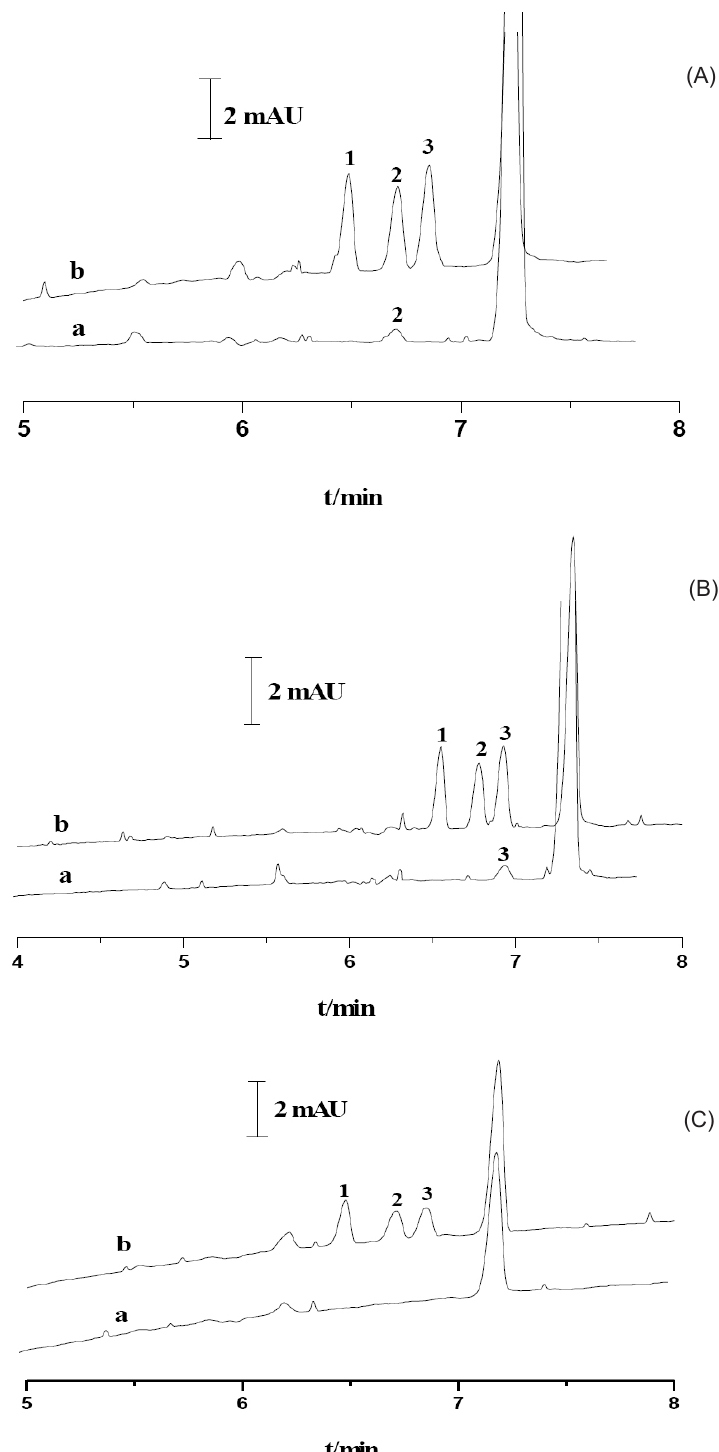
Figure 4. Typical electropherograms of (A) lake water (B) river water and (C) reservoir water samples without (a) and with (b) standards addition after DLLME extraction under the optimum conditions. The spiked concentration of PAs standards was 100.0 ng mL -1 . Peaks: 1: